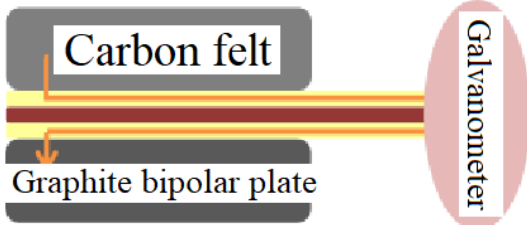
Figure 2. Schematic diagram of operating principle of micro current sensor.